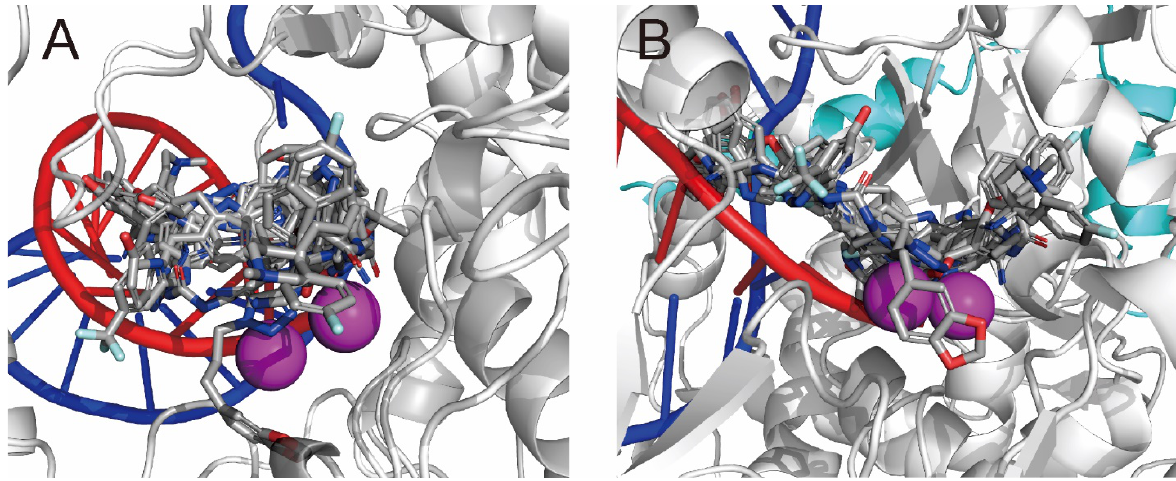
Figure 5. Superposition of the most stable docking modes of the top-scoring eight bioactive com- pounds obtained from the AutoDock Vina docking simulations. ( A ) Front view and ( B ) side view of the active site. The RdRp (nsp12) and nsp8 subunits are presented as white and cyan ribbons, respectively. The primer and template RNAs are presented as red and blue coils, respectively. The bioactive compounds are presented in CPK color using tubes. The magnesium ions are presented as magenta spheres.